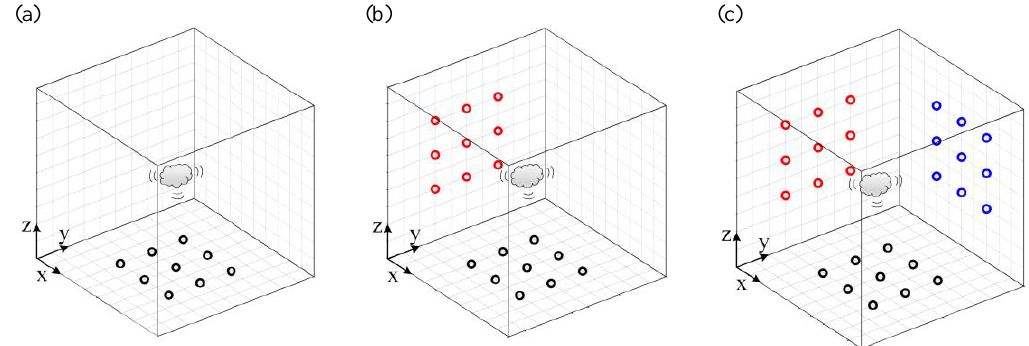
Figure 4. ( a ) Non-synchronous original microphone array in the x–y plane (black circles); ( b ) non-synchronous moving microphone array in space from the x–y plane to the y–z plane (red circles); ( c ) non-synchronous moving microphone array in space from the x–y plane to the x–z plane (blue circles). The circle “ ○ ” represents a microphone, and the same color represents the microphones in the same test.